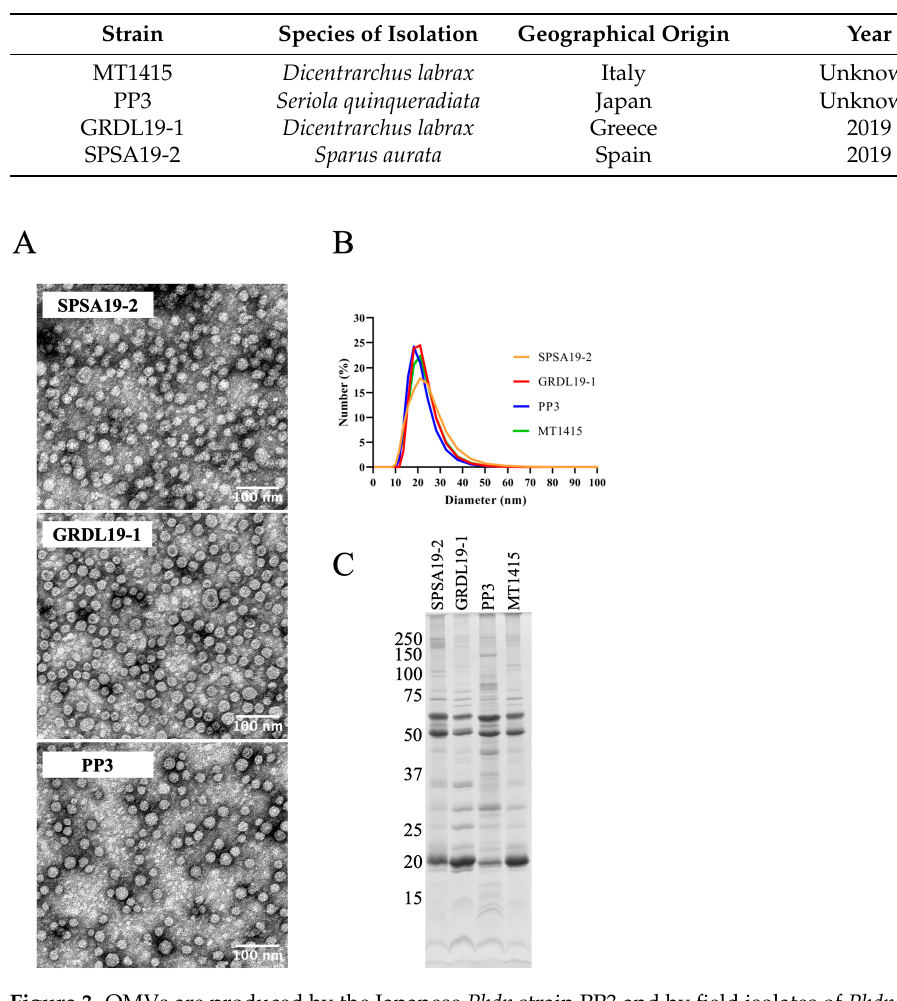
Figure 3. OMVs are produced by the Japanese Phdp strain PP3 and by field isolates of Phdp . ( A ) TEM of negatively stained crude OMVs from strains SPSA19-2, GRDL19-1, and PP3. ( B ) Dynamic light scattering analysis of the particle size distribution of purified OMVs. Each line corresponds to the average of two independent measurements of the same OMVs preparation. ( C ) SDS-PAGE analysis of crude OMVs. Samples were subjected to SDS-PAGE/Coomassie Blue staining. Each lane contains OMVs equivalent to 30 mL of a late exponential bacterial culture (OD 600nm of 0.9). Numbers at the left indicate the position and mass of the molecular weight markers, in kDa. The uncropped gel can be found in Figure S1.